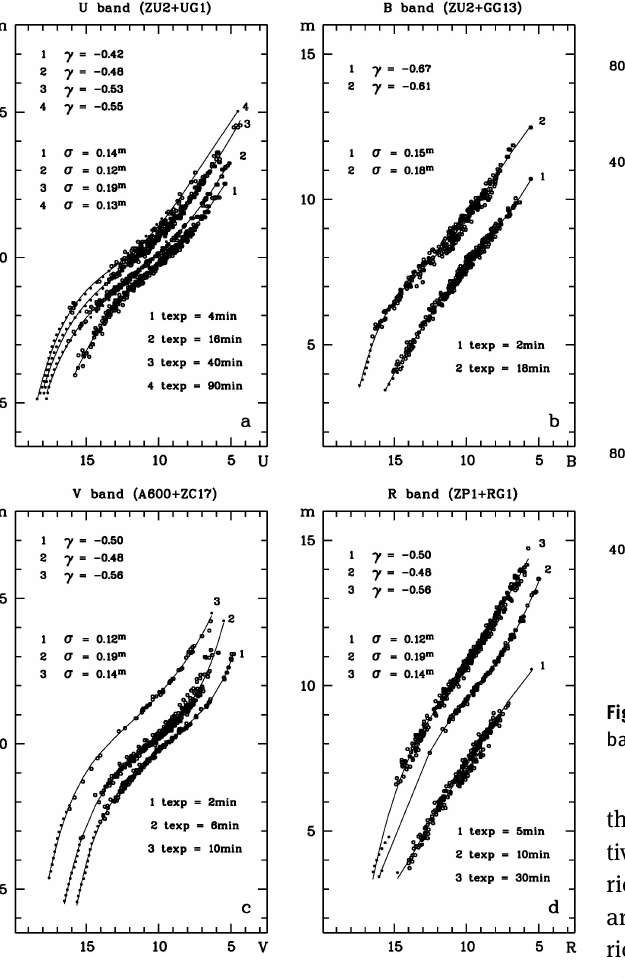
Figure 8. Characteristic curves with different exposures for as- tronegatives captured in four UBVR bands of the Johnson system at the 1.2m Baldone Schmidt telescope. R measurements of stars and an empirical characteristic curvewereused.Fordifferentexposures,fourcharacteristic curves for passband U (panel a), two characteristic curves for passband B (panel b) and three characteristic curves for passband V and R (panels c and d, respectively) are shown. Designations in Figure 8 are the following: points – cor- rected for contrast γ data from the empirical curve, circles – data on photoelectric measurements of stars in the UBVR system. For each characteristic curve, the exposure time, the values of the contrast coefficients γ and the errors in constructing the characteristic curves σ are indicated.